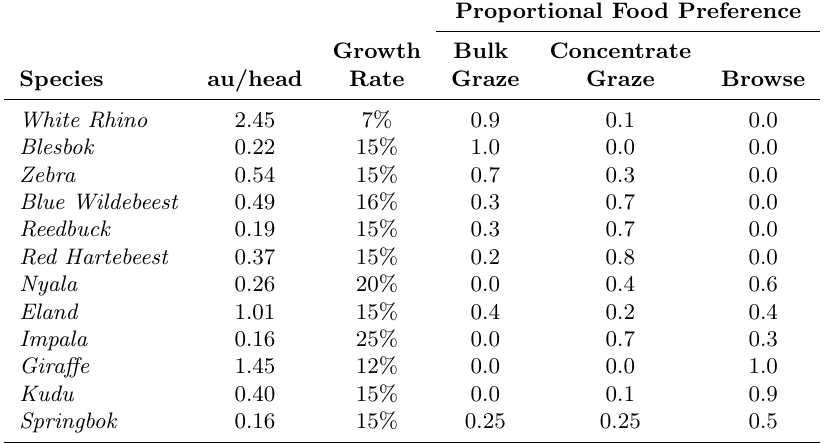
Table 1: List of species, animal units per head, growth rates, and the proportions of each food type in their preferred